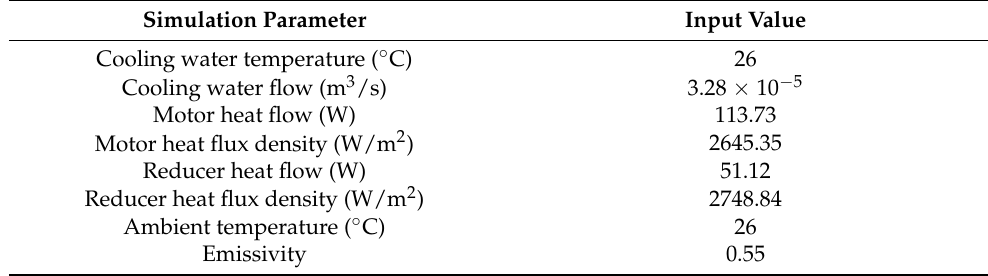
Table 3. Simulation parameters of the motor-reducer system.